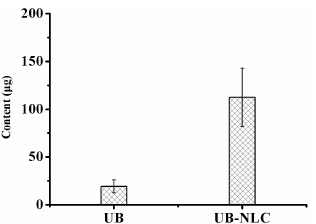
Figure 3. Skin deposition of UB in NLC compared with ethanol solution in dermatomed rabbit skin. Data have been expressed as the mean and standard deviation.